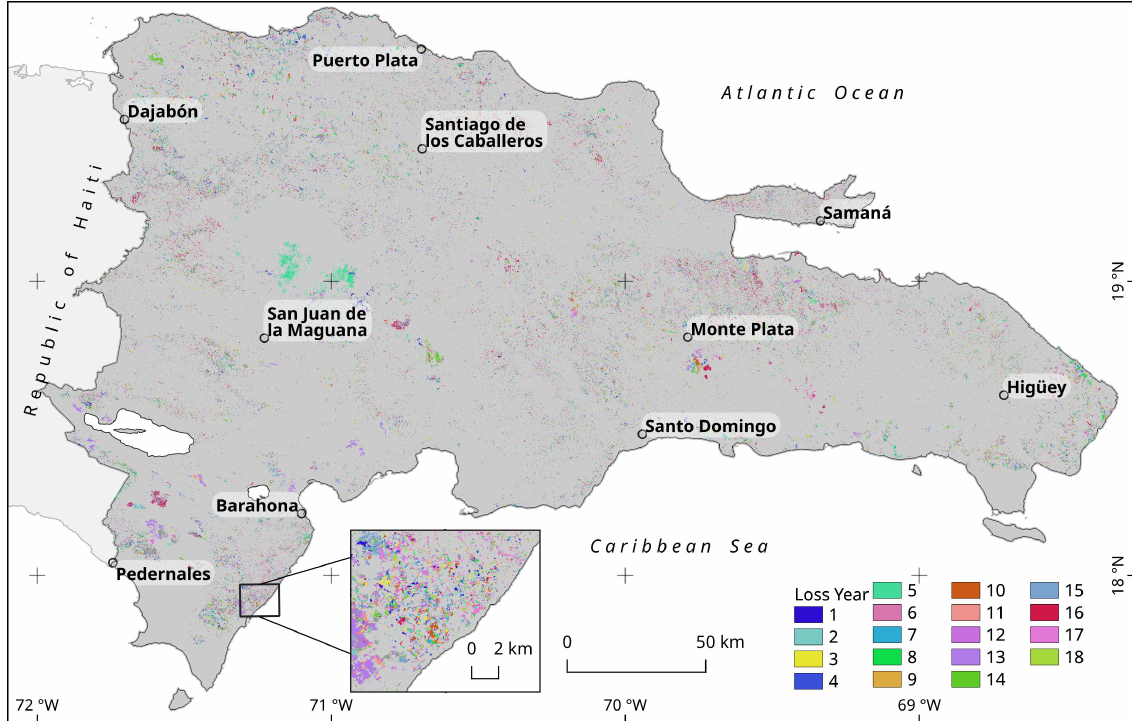
Figure 2 – Loss year layer from 2001 to 2018 for the Dominican Republic, according to MC Hansen et al. (2013). Labelled points denote the location of some cities chosen as